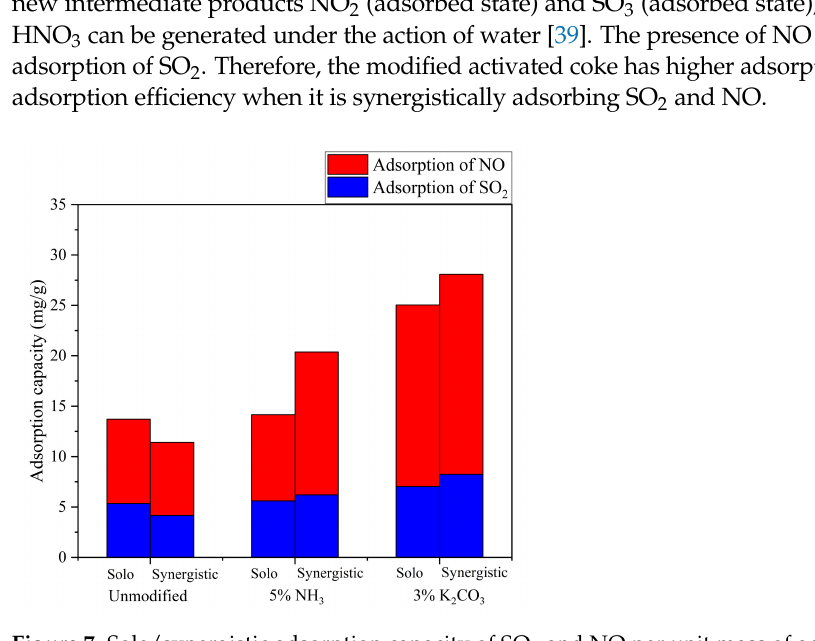
Figure 7. Sole/synergistic adsorption capacity of SO 2 and NO per unit mass of activated